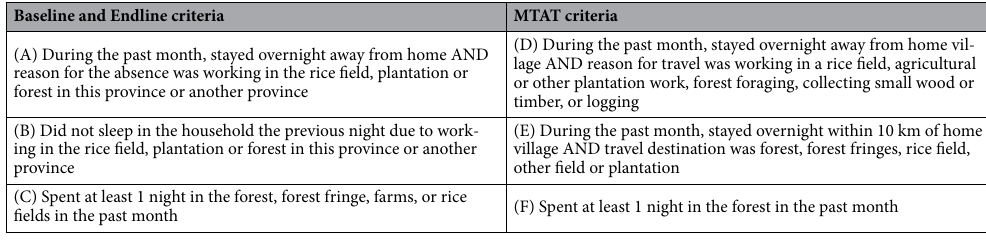
Table 1. HRP eligibility criteria .